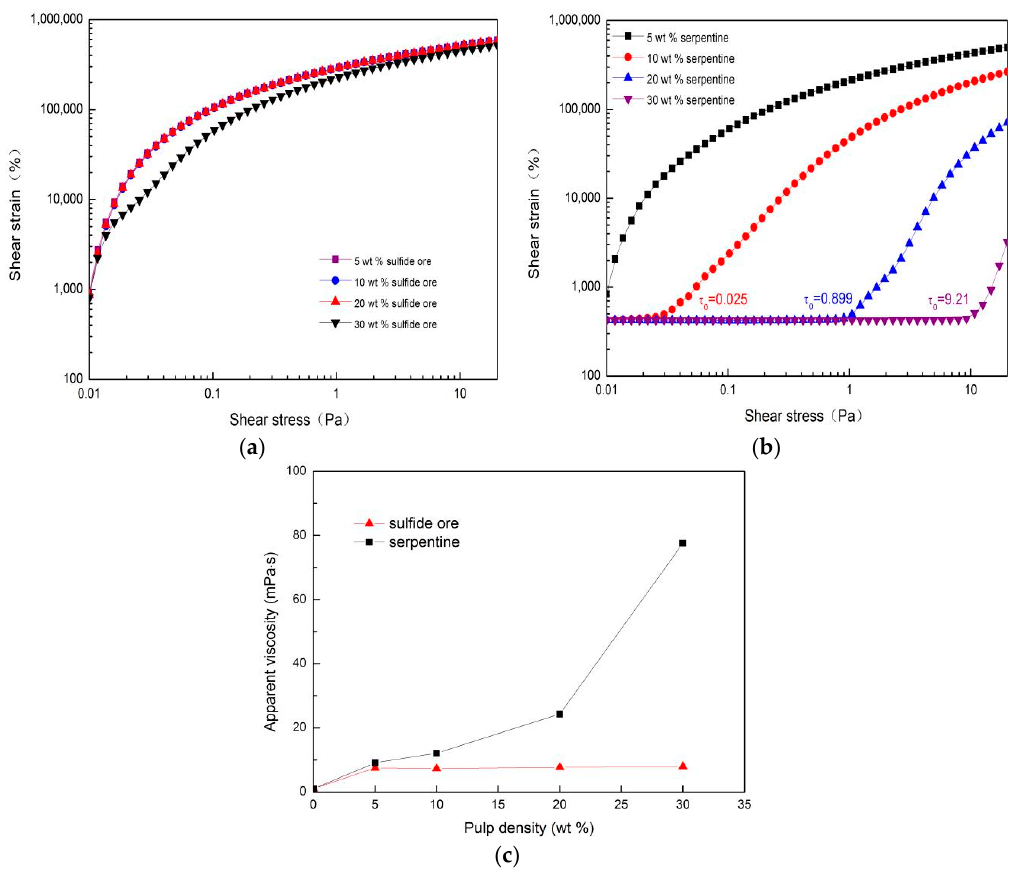
Figure 2. Comparison of shear stress vs. shear strain curves between: ( a ) single sulfide; ( b ) serpentine with different pulp densities; and ( c ) apparent viscosity as a function of pulp density at the shear rate of 100 s − 1 .